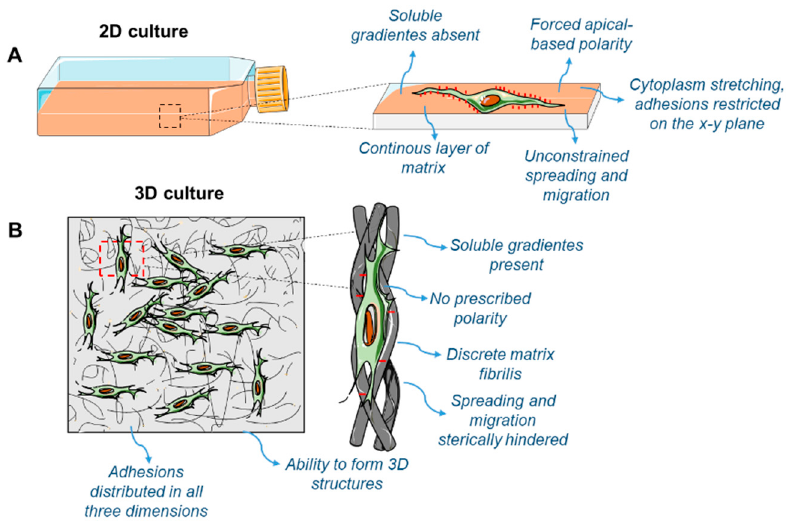
Figure 3. Comparison between 2D-cell culture ( A ) and 3D-cell culture ( B ). Cells cultivated in 2D demonstrate environmental behavior and constraints, whereas when grown in 3D culture systems, they feature increased complexity, to simulate increased faithfulness to the in vivo